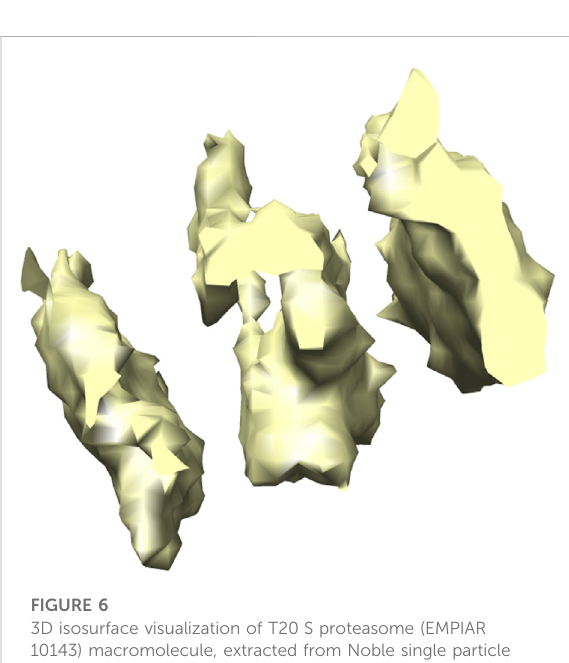
FIGURE 6 3D isosurface visualization of T20 S proteasome (EMPIAR 10143) macromolecule, extracted from Noble single particle dataset.